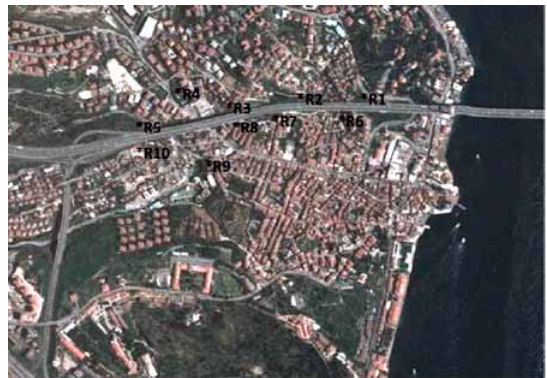
Fig. 4. Google Earth view of the European side link road of the Bosporus Bridge (2015) and noise measurement points